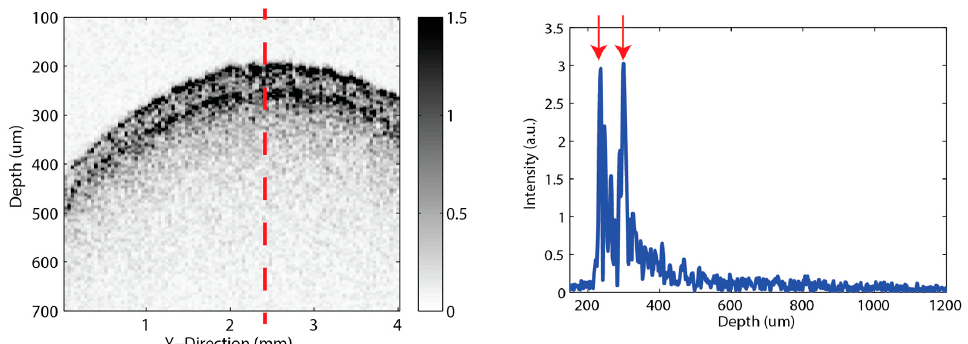
Figure 3. A 100 × 100 B-scan of a biconvex-shaped pharmaceutical tablet with the tablet central region annotated by the dashed line ( left ) and the respective A-scan with the air-coating and coating–core interfaces annotated by the respective arrows ( right ). Adapted from [23].